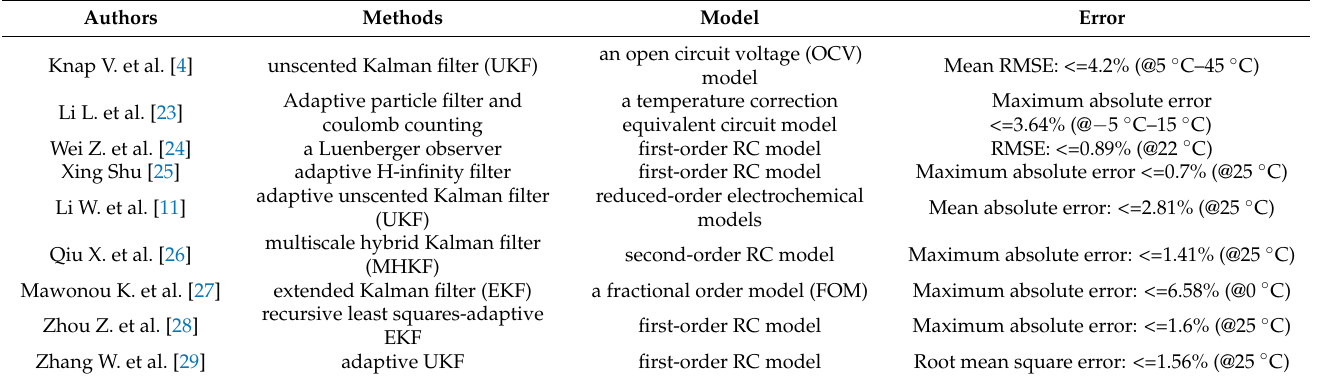
Table 1. Typical Kalman-based methods for SOC estimation.